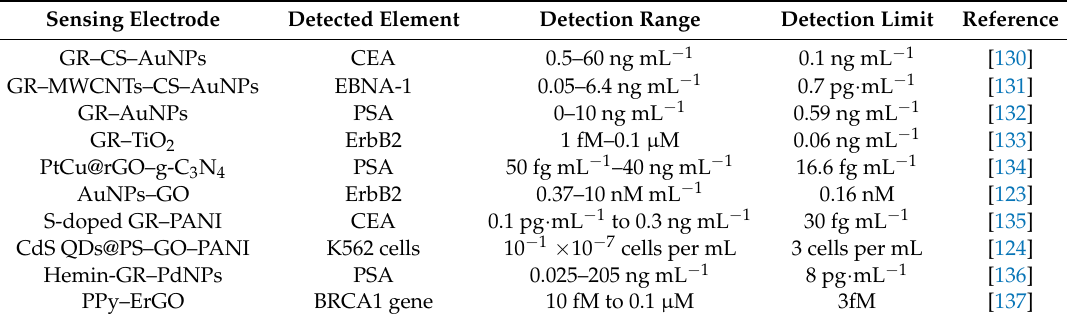
(cid:13) (cid:13) ; ( B ) [127], Elsevier c ;